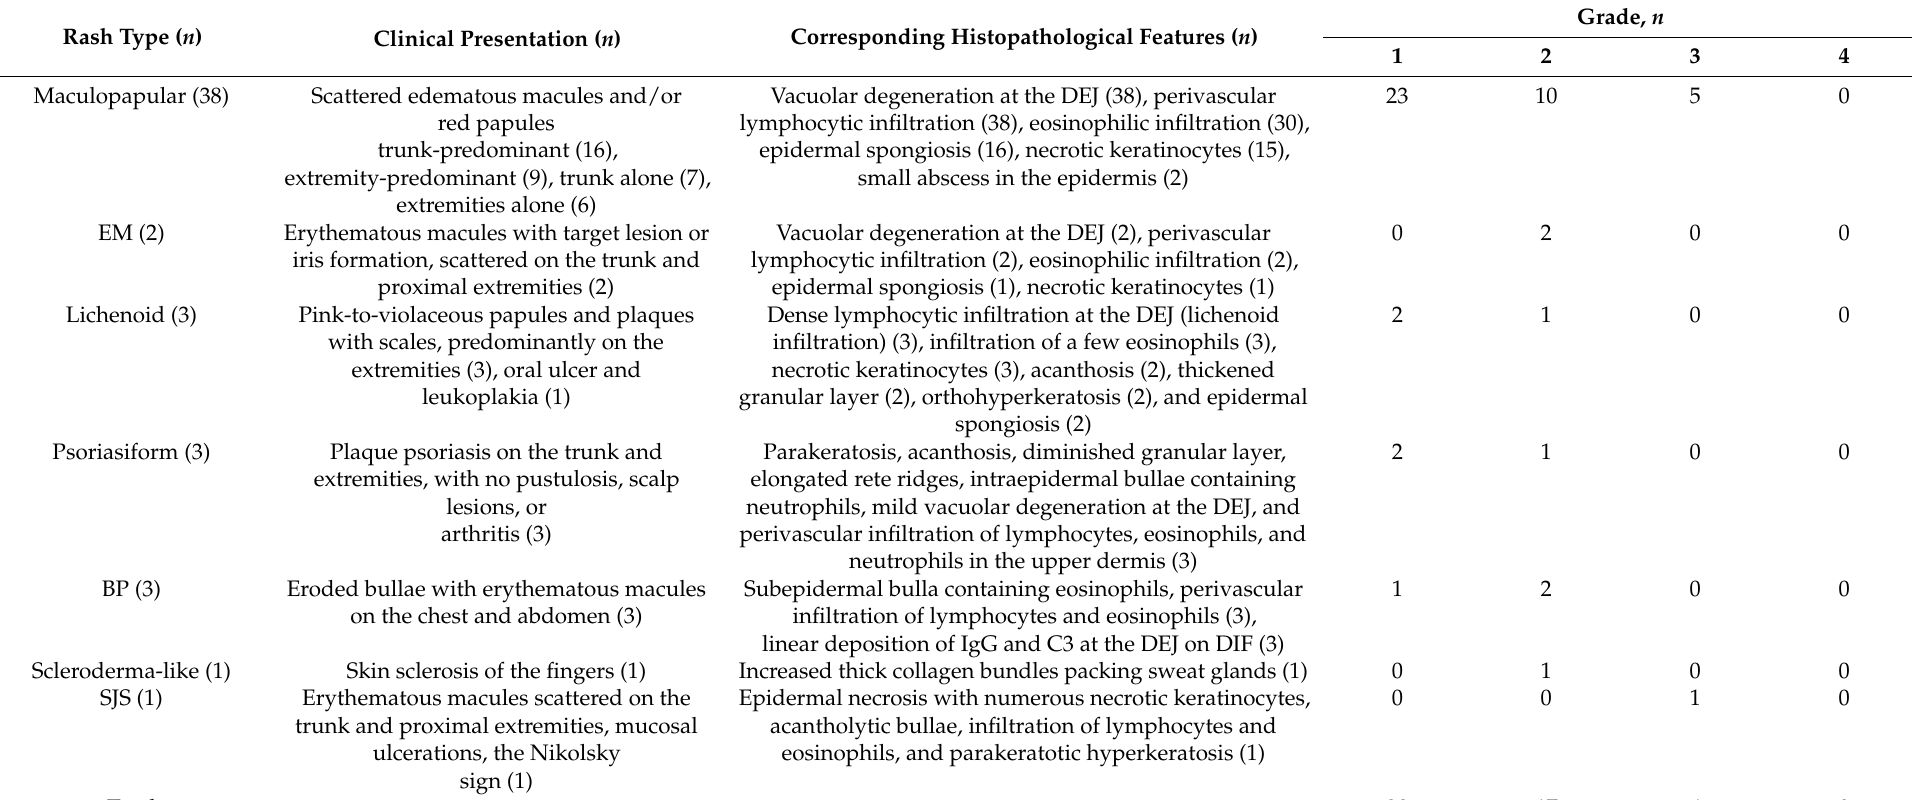
Table 2. Clinical and histopathological findings and the grade of inflammatory